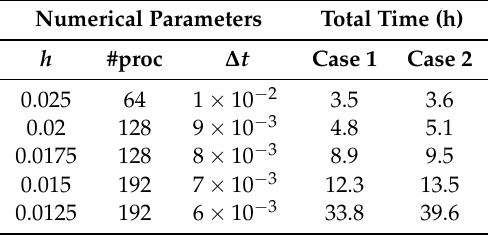
Table 3. Numerical parameters used for simulations and resulting simulation times for each test